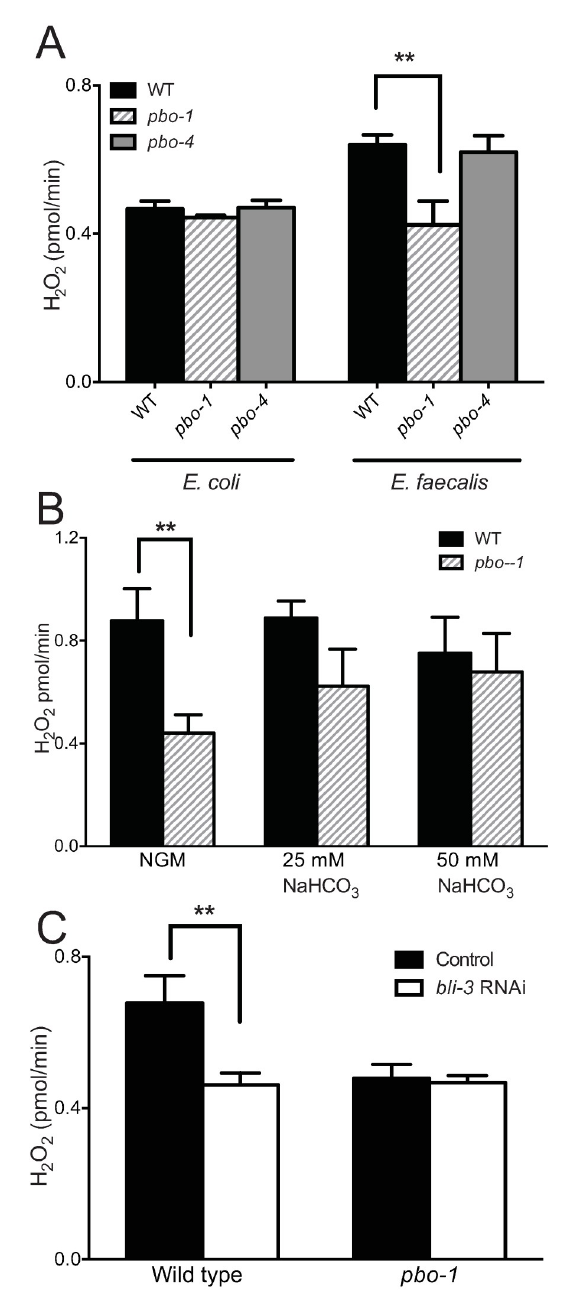
Fig 7. Amplex Red H 2 O 2 measurements in E . faecalis -fed worms. (A) PBO-1, but not PBO-4, is important for H 2 O 2 production in response to E . faecalis . (B) H 2 O 2 is restored to a pbo-1 mutant by adding bicarbonate (NaHCO 3 ) to the nematode growth medium. (C) RNAi downregulation of bli-3 does not further decrease H 2 O 2 production in E . faecalis- fed pbo-1 mutants. Worms were exposed to bli-3 RNAi E . coli mixed with the E . coli empty vector strain at a 1/ 10 dilution for 3 days prior to feeding with E . faecalis . Results are of three independent experiments with 30 worms each. Error bars represent standard deviation. �� , statistically different by student’s t-test ( p < 0.01). For part B, wild type and pbo-1 were not statistically different on NGM + bicarbonate ( p > 0.4). For part C, pbo-1 mutants exposed to bli-3 RNAi were not statistically different from those exposed to the vector control ( p > 0.5).